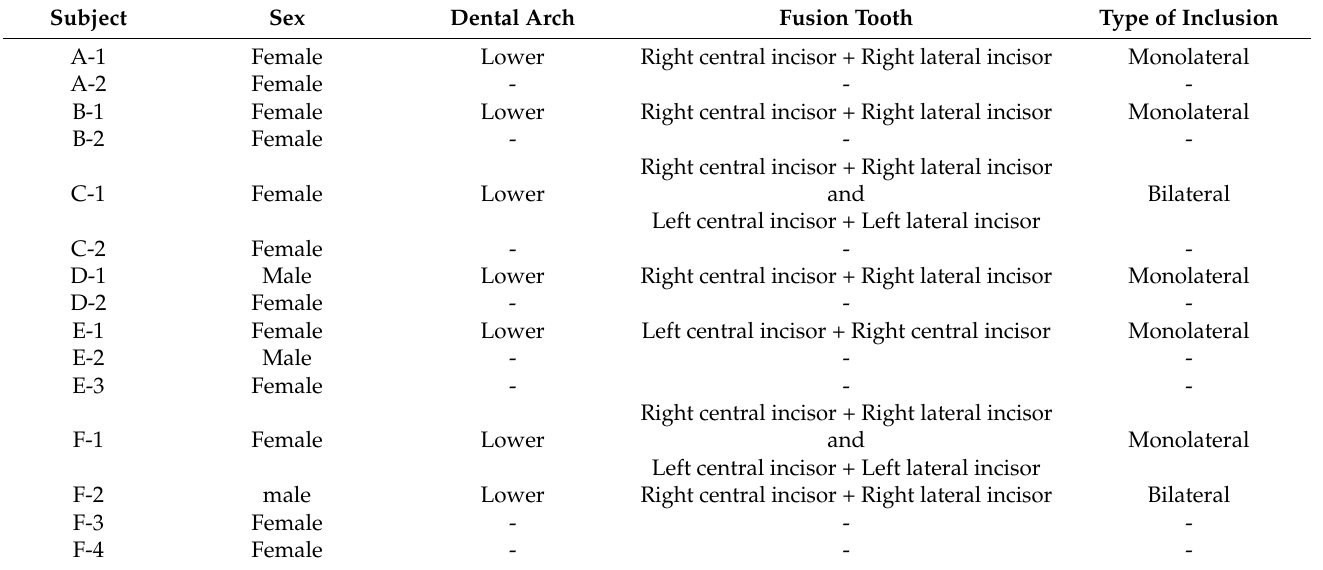
Table 1. Clinical characteristics of the 15 patients from families